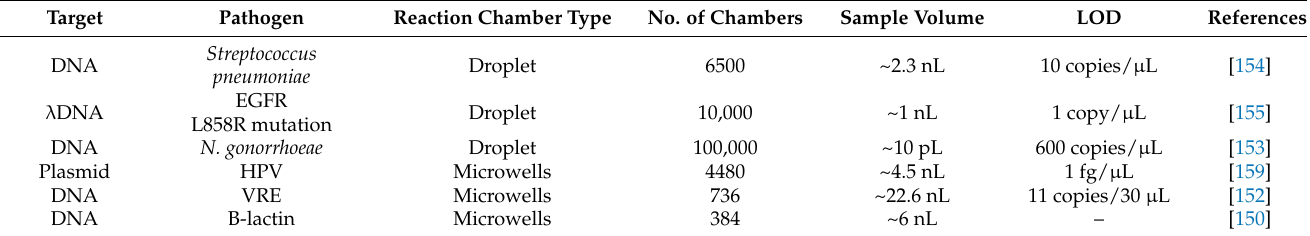
Table 4. Comparisons of various digital LAMP